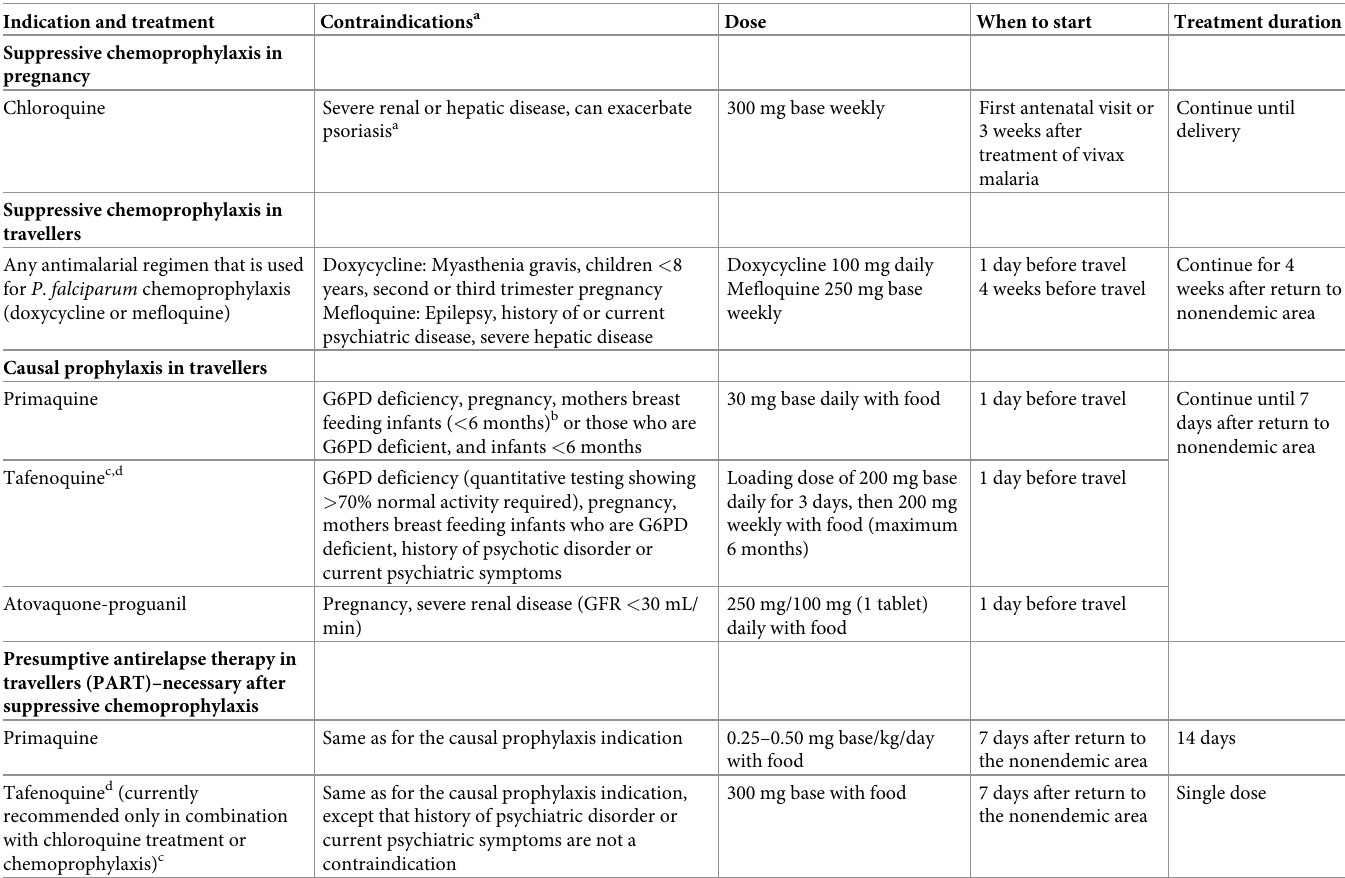
Table 1. Chemoprophylactic regimens against Plasmodium vivax